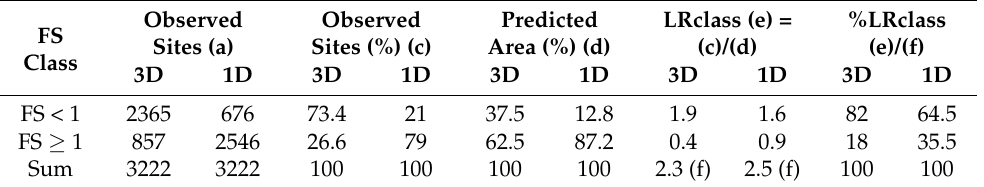
Figure 9. ( a ) Factor of safety spatial distribution as a result of 1D slope stability analysis (Simulation I); ( b ) factor of safety spatial distribution as a result of 3D slope stability analysis (Simulation II); ( c ) cumulative frequency of the factor of safety resulting by both 1D and 3D models. Table 5. Comparison of LRclass index obtained with the 3D and 1D approaches, both calculated at 9 p.m. on 27 April